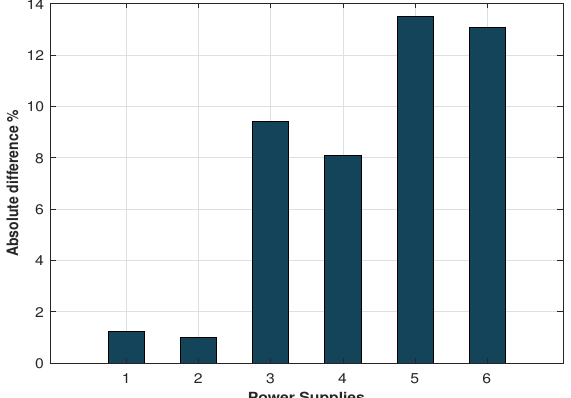
Figure 9. Current RMS difference between Cold and Stable